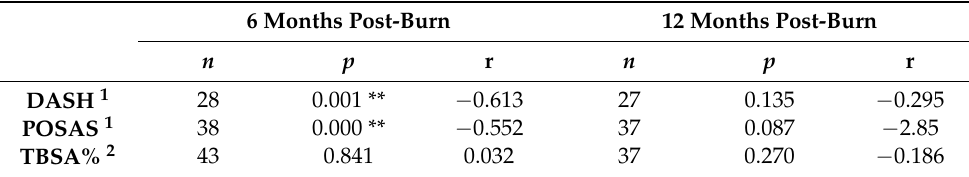
Table 2. Correlations with the self-rated health (EQ VAS) and otherassessments. 6 Months Post-Burn 12 Months Post-Burn